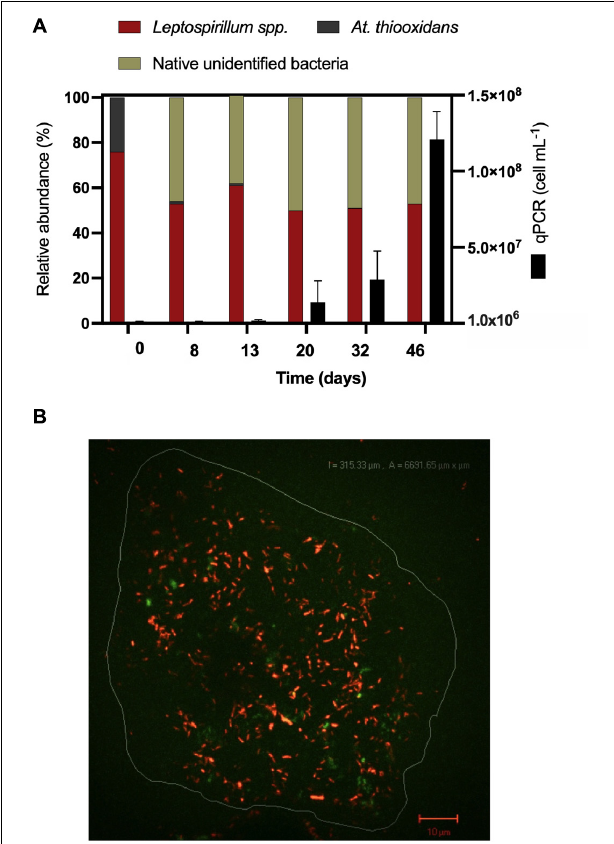
bioleaching under mesophilic (30 ◦ C) inoculation with external ferrous iron (Fe 2 + ) addition in laminar flow bioleaching (flow cell method). (A) Microbial dynamics in the recirculating solution via qPCR and cell counts. (B) Representative biofilm composition by FISH (30 days) where the image corresponds to overlap of FISH-Cy3 (red, Acidithiobacillus spp.) and FISH-FAM (green, Leptospirillum